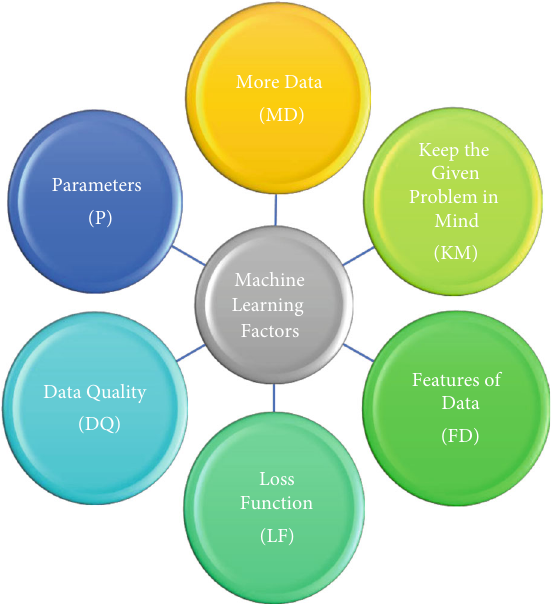
Figure 2: Summary of